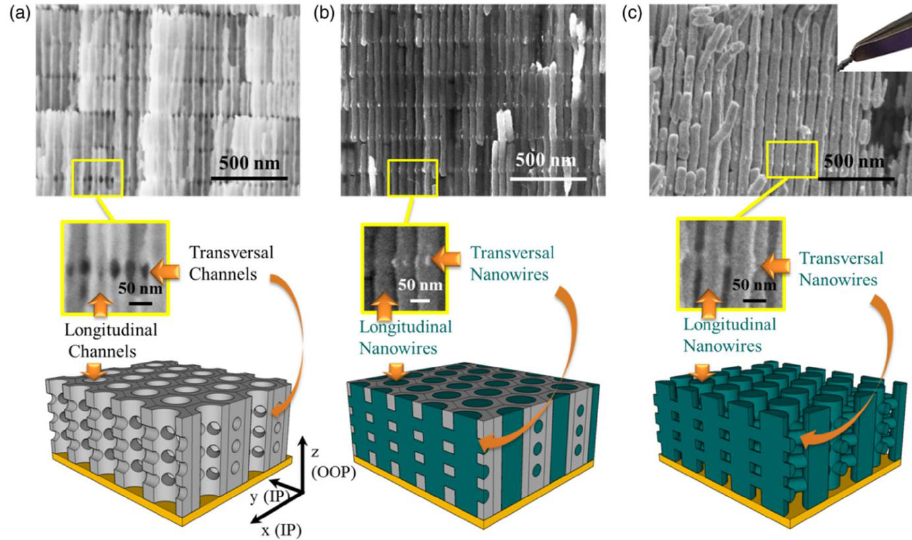
Figure 13. SEM images and schematics presenting template-assisted fabrication of 3D magnetic alloy network. ( a ) Raw alumina template, ( b ) structure infiltrated with magnetic alloy, and ( c ) 3D network of magnetic nanowires. Reprinted with permission from [183]. Copyright 2019 Wiley.